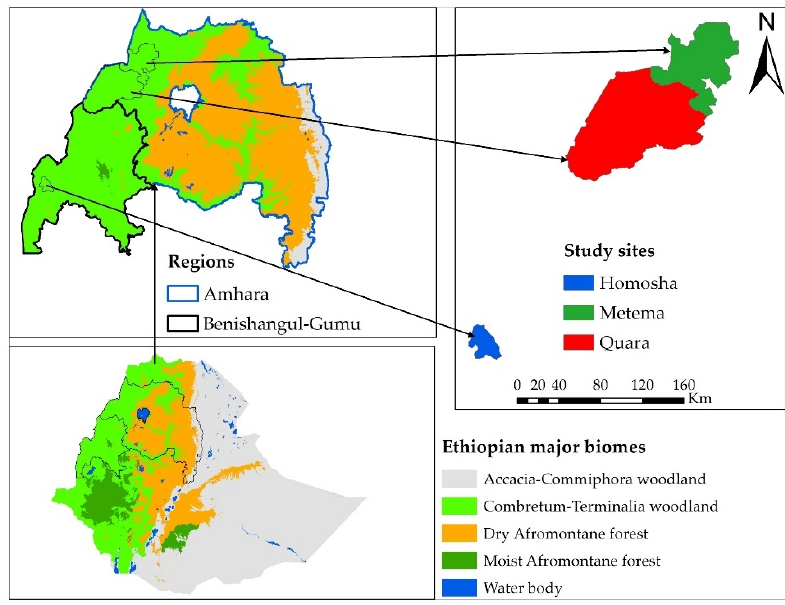
Figure 1. Map of the study sites and Combretum-Terminalia woodland and wooded grassland.